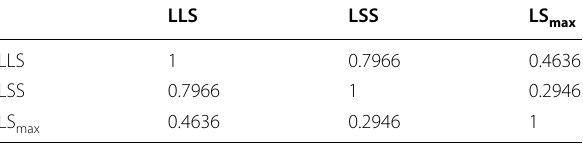
Table 2 Correlation matrix of all